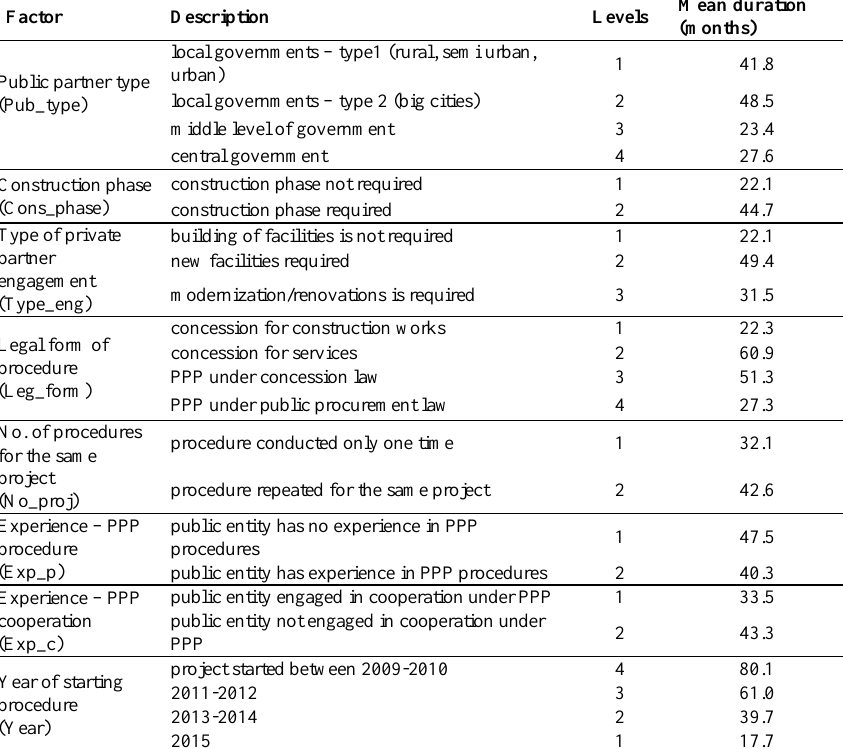
Table 1. Mean duration for the levels of each factor